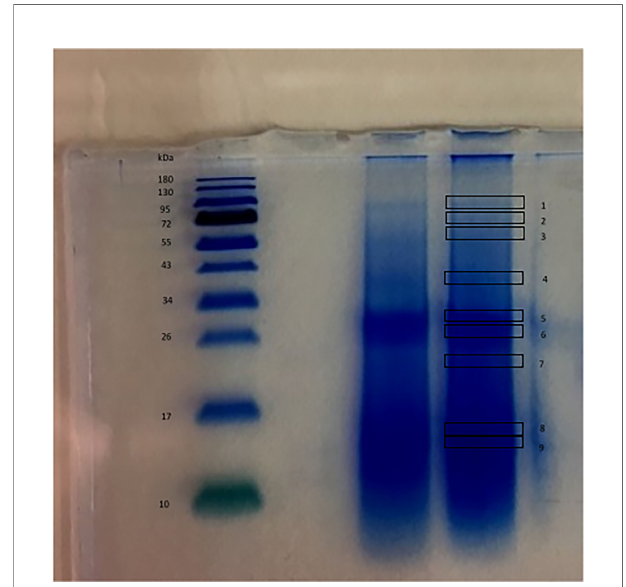
FIGURE 1 | SDS-PAGE of the 20 m g of proteins extracted from the spicules of P. fi ciformis . MW standard (left) and two lines containing the proteins extracted (on the right). The numbers indicate the position of the slices cut for proteins extraction and MS